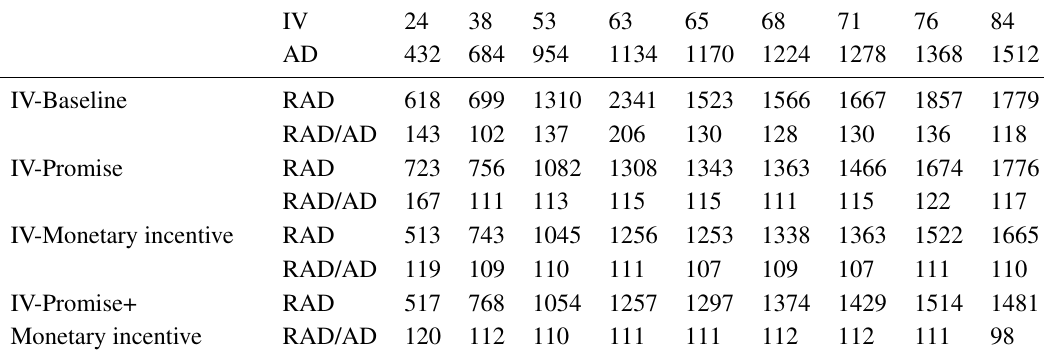
Table 4: Aggregate bidding behavior by treatment and induced value